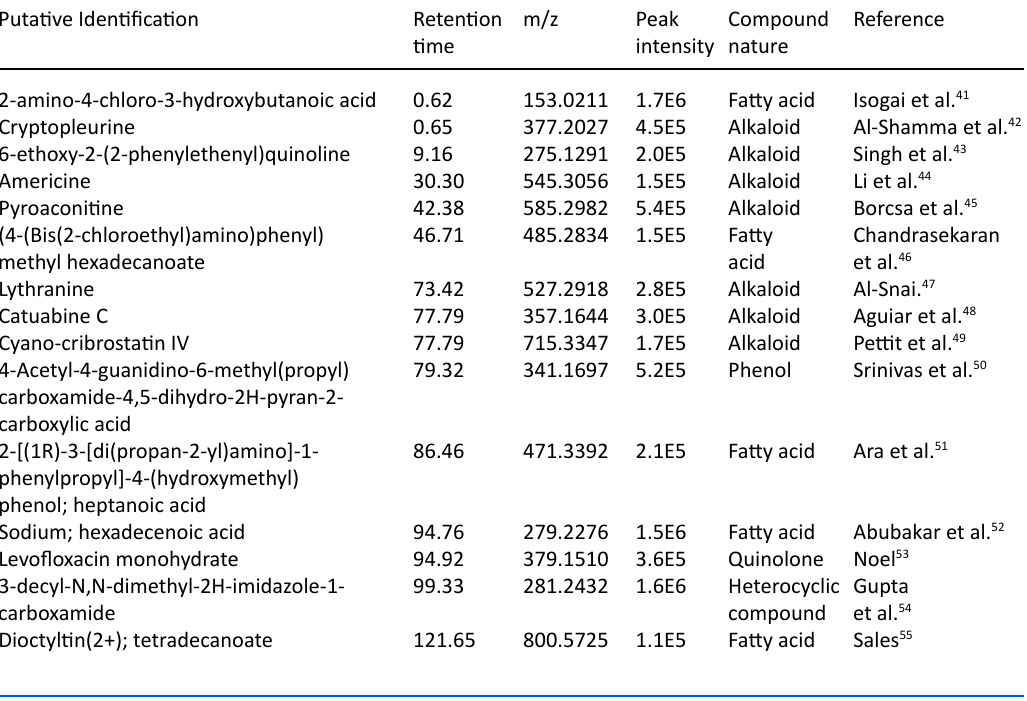
table 4. Putative compounds identification of ethyl acetate crude extract of G. boninense from PubChem by HPLC coupled with electrospray ionization mass spectrometry system Putative